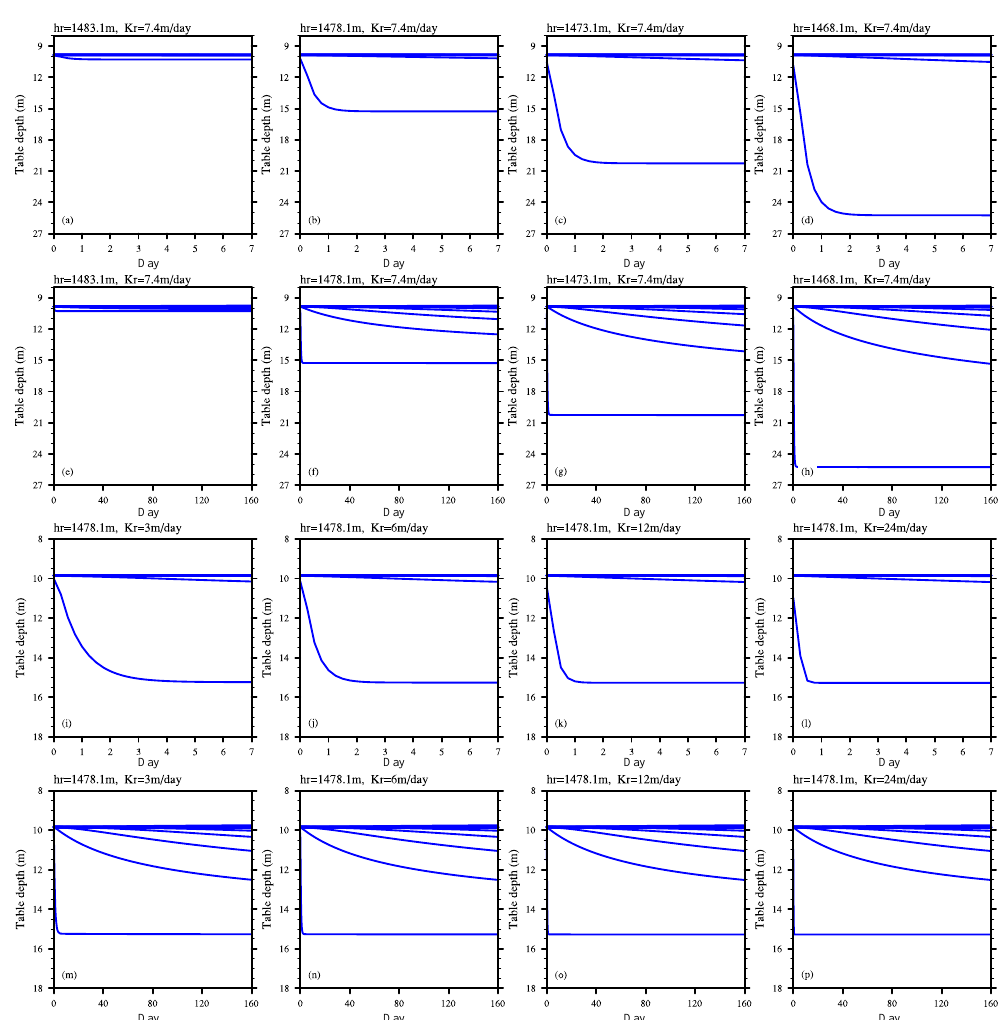
Figure 5. Short-term (a–d , i–l) and long-term (e–h , m–p) responses of the riparian groundwater table to the river water level h r and riverbed hydraulic conductivity K r in the case of the groundwater recharging the river. Time series of the simulated groundwater table depths for each grid cell in the first sensitivity experiment (a–h) . Time series for the second sensitivity experiment (i–p) .